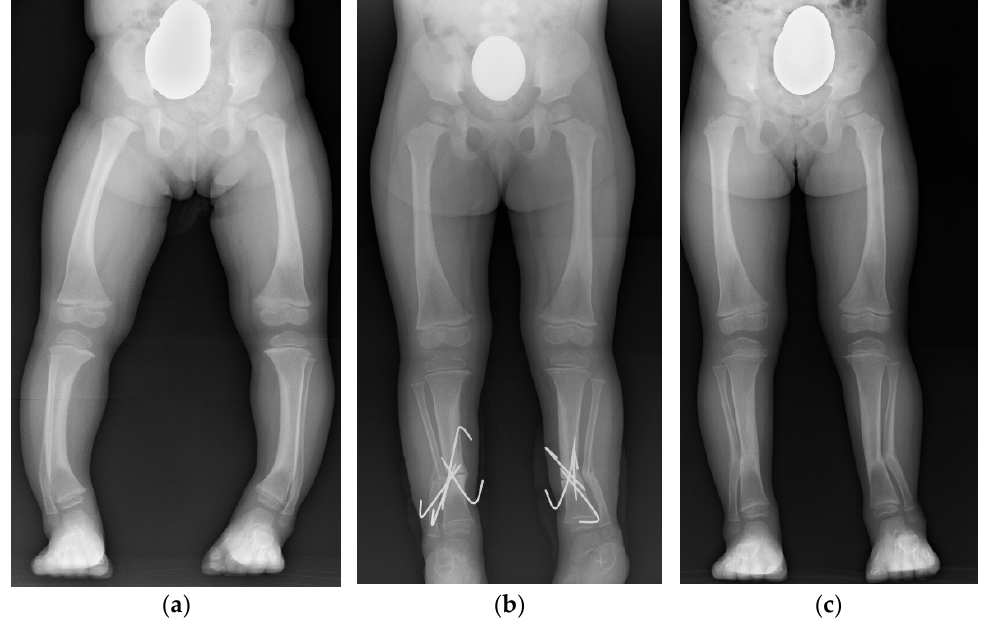
Figure 2. A case of correction osteotomy: ( a ) varus deformities of bilateral lower legs before correction osteotomy; ( b ) corrected lower legs after bilateral osteotomy with wire fixation; ( c ) correction of MAD after bone healing at osteotomy site.